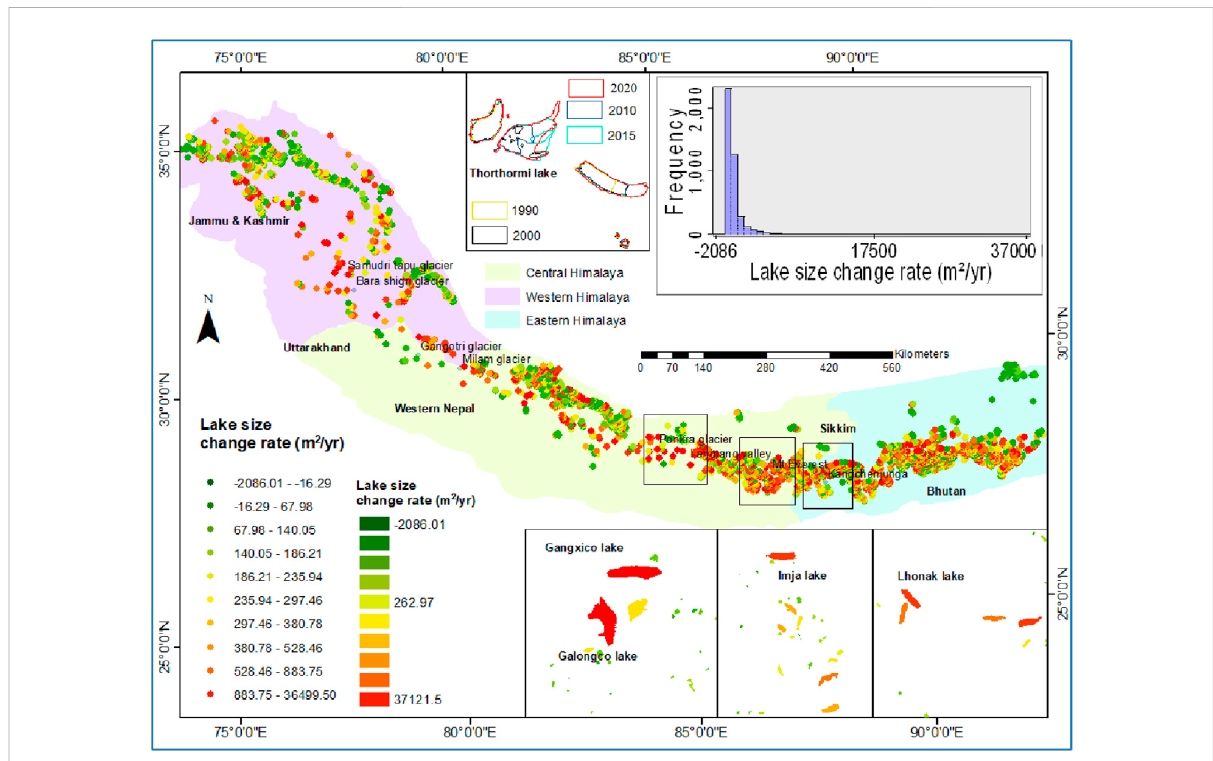
FIGURE 2 Lake size change rate map of the Himalaya; here, red color shows the highest positive, whereas green shows the lowest negative lake size change. In the zoom box important lakes were shown in different part of the Himalaya with their lake size change rate and different years of lake boundary polygon. In the histogram plot, the distribution of lake size change rate shown for the